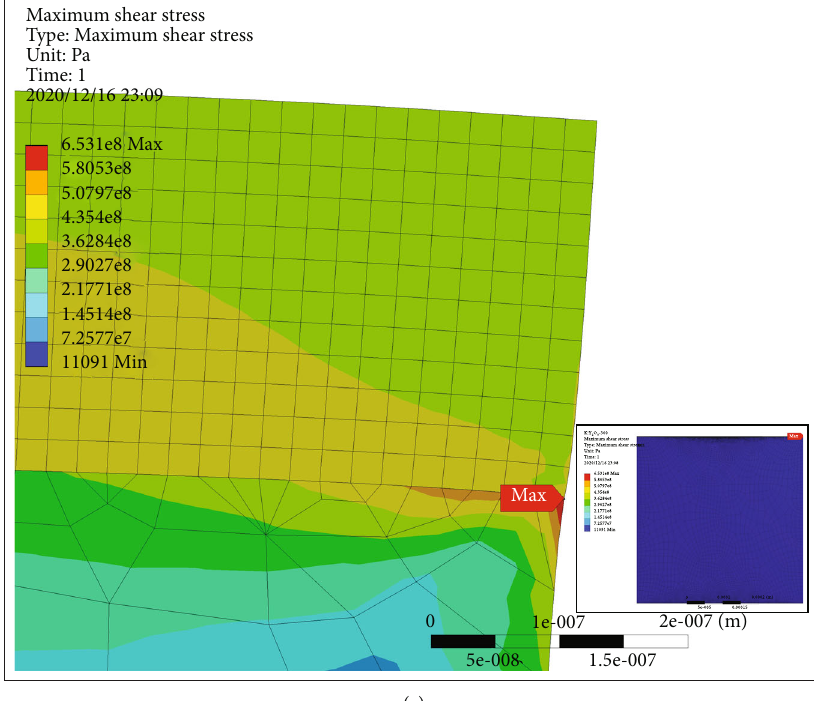
O , t = 300nm ); 2 3 O , t = 300nm ); (f) max Mises 2 3